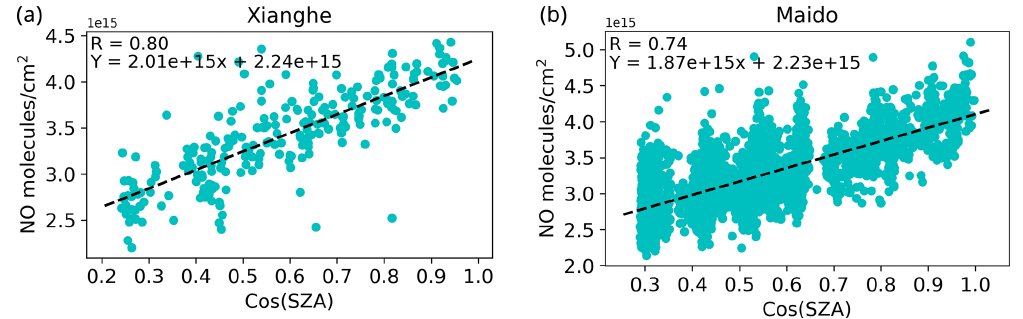
Figure 7. The correlation between the stratospheric NO partial column and the solar radiation (cos ( SZA ) ) before 12:20LT at Xianghe (a) and Maïdo (b) , respectively. R is the correlation coefficient, N is the measurement number, and the dashed black line is the linear